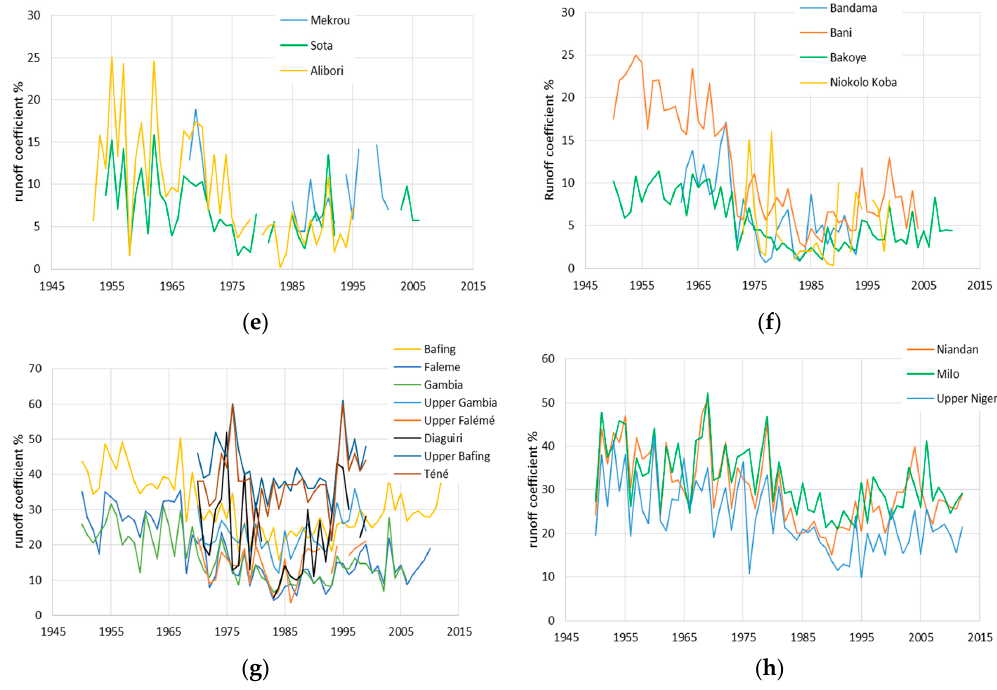
Figure 4. Interannual evolution of RC for the different types of hydrological behavior: ( a ) type 1: great basins: strong decrease during drought, long time in recovering RC; ( b ) type 2: pure Sahelian functioning: increase during drought, exacerbated after the rainfall recovery; ( c ) type 3: Sudano-Guinean type with partial RC recovery; ( d ) type 3-2: Sudano-Guinean type with total RC recovery (but short series, with numerous missing data); ( e ) type 3-3: Sudano-Guinean type with little partial RC recovery (but short series, with numerous missing data, overall after the drought); ( f ) type 4: pure Sudanian type without or with very little RC recovery; ( g ) type 5-1: pure Guinean type with high values of RC, granitic basement sub-type (low WHC of the basins); the break of RC appears around 1975–1977; ( h ) type 5-2: pure Guinean type with high values of RC, “eastern” sub-type with high WHC of the basins; the break of RC appears around 1979–1980.